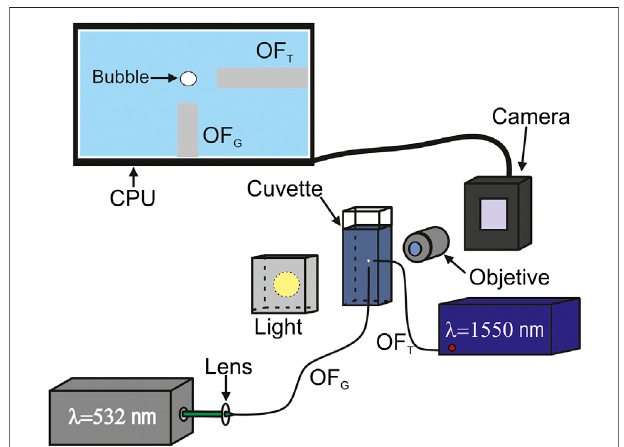
FIGURE 1 | Experimental set up for generation and trapping of microbubbles. The microbubbles are generated at fi ber OF G using a pulsed laser ( λ (cid:1) 532 nm, τ p (cid:1) 5 ns) and trapped at fi ber OF T using a CW low power laser ( λ (cid:1) 1550 nm, Power 1 – 15